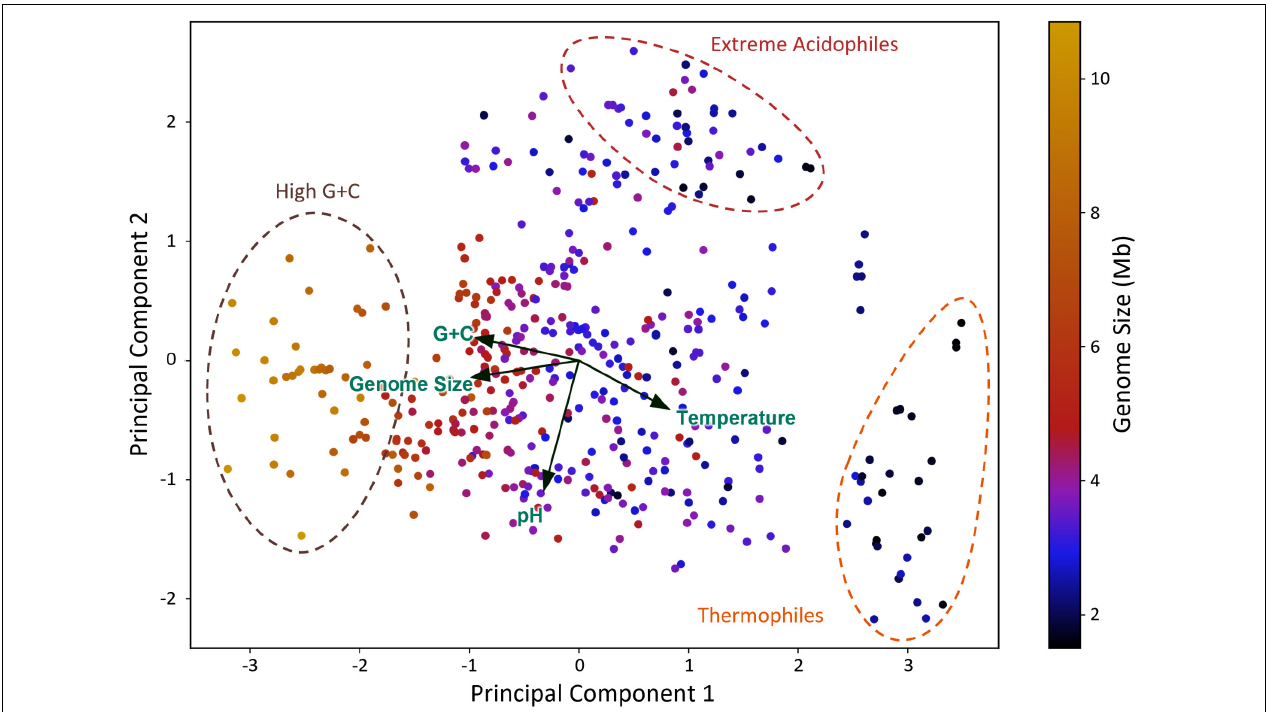
FIGURE 4 | Principal component analysis (PCA) of multiple variables potentially influencing the genome size. Dimensionality reduction was performed by PCA, inputting the optimal growth pH, optimal growth temperature, G + C content, and genome size of each species in the dataset. A biplot was constructed, which shows the loadings of each variable as arrows at the center of the plot and the distribution of the principal components. The average genome size of each species is shown as a color scale. Three clusters within the dotted circles are highlighted for their distinctive